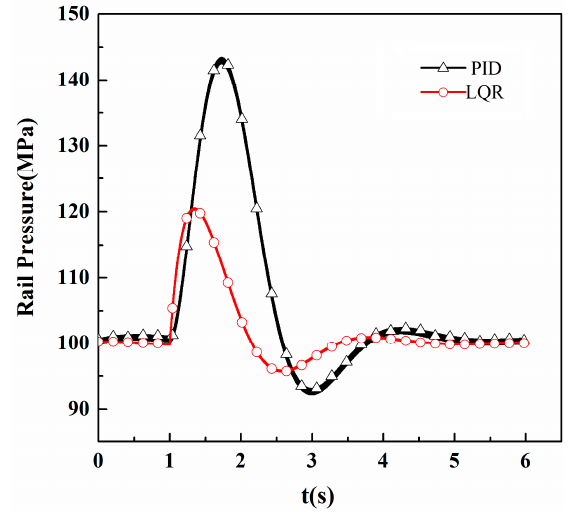
Figure 16. Comparison of rail pressure overshoot controlled by PID & LQR.